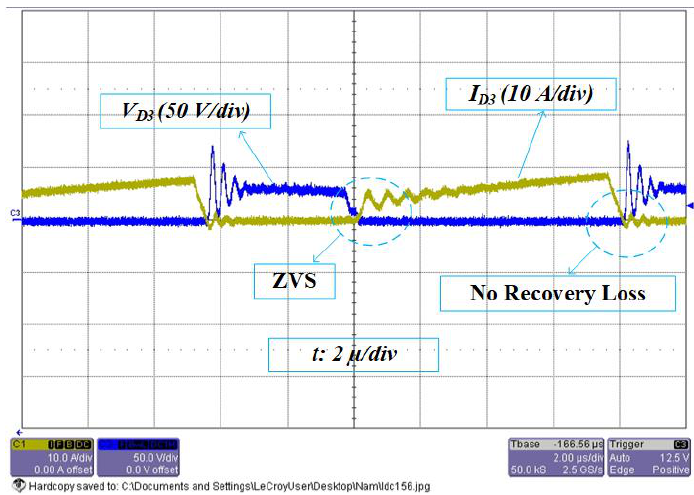
Figure 16. Voltage and current of diode 𝐷 3 at 100% of load.